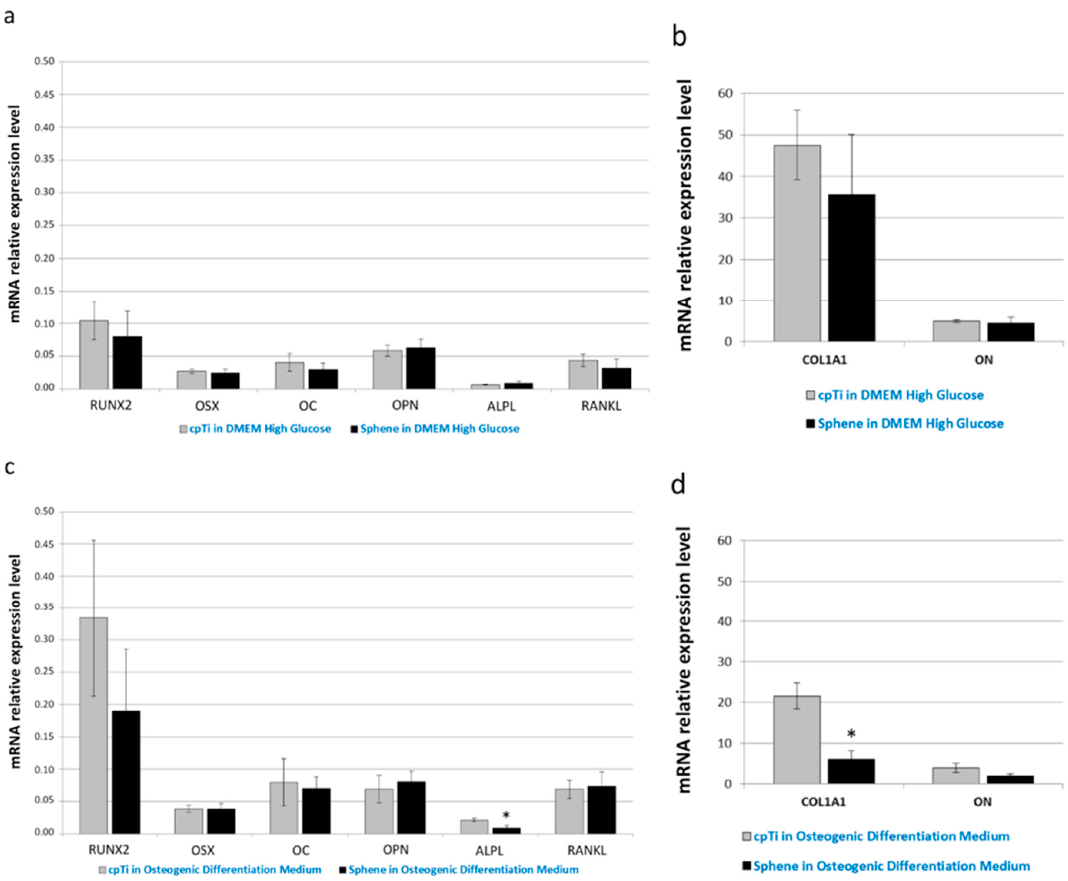
Figure 9. Real-time PCR analysis of the osteogenic differentiation markers runt-related transcription factor 2 (RUNX2), osterix (OSX), collagen type I (COL1A1), osteocalcin (OC), osteonectin (ON), osteopontin (OPN), alkaline phosphatase (ALPL), and receptor activator of nuclear factor kappa-B ligand (RANKL). Data are normalized to the expression of the transferrin receptor (TFRC) internal reference. Gray bars indicate the relative expression level of the selected genes in the hADSCs seeded onto cpTi samples in DMEM High Glucose ( a , b ) or Osteogenic Differentiation Medium ( c , d ) for 21 days. Black bars represent the gene expression level of the same markers in the hADSCs seeded onto Sphene samples in DMEM High Glucose ( a , b ) or Osteogenic Differentiation Medium ( c , d ) for 21 days.